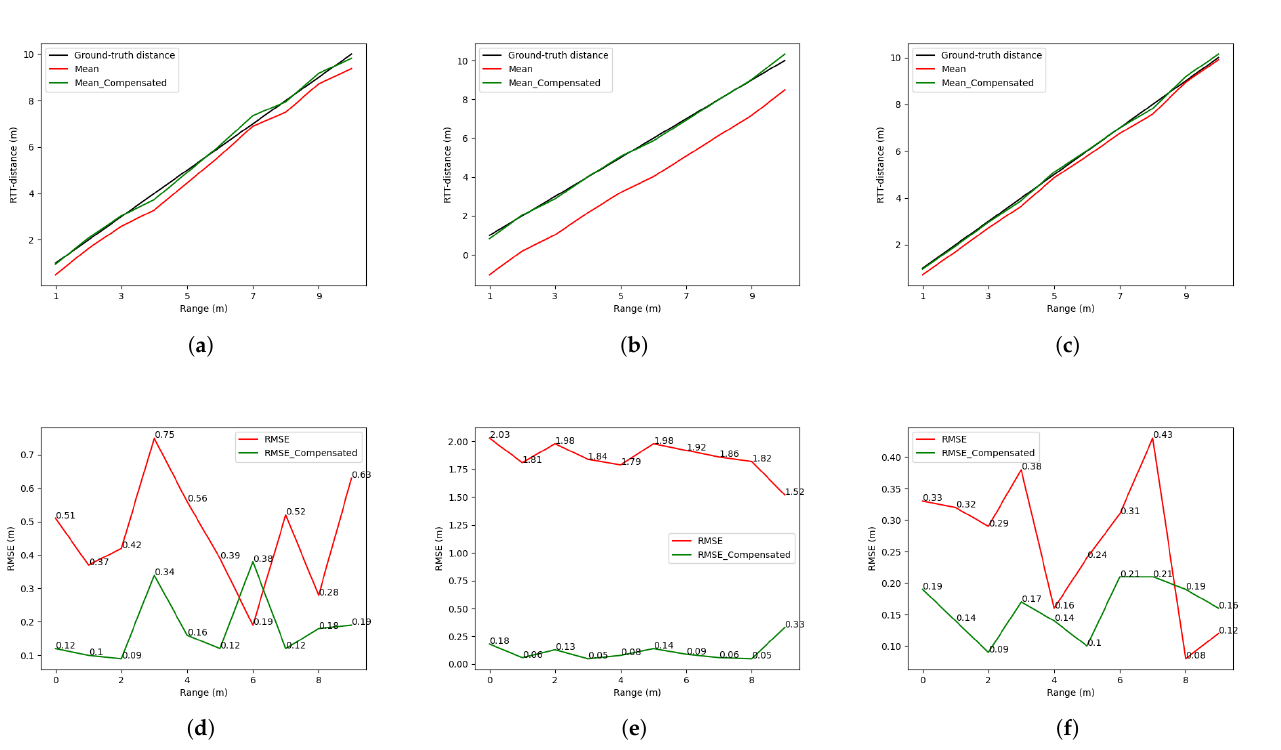
Figure 8. Wi-Fi RTT distance and error in RFPF and LOS condition: ( a ) Wi-Fi RTT distance from Google Pixel 2; ( b ) Wi-Fi RTT distance from Xiaomi Redmi K20; ( c ) Wi-Fi RTT distance from LG V50S; ( d ) RMSE of Wi-Fi RTT distance from Google Pixel 2; ( e ) RMSE of Wi-Fi RTT distance from Xiaomi Redmi K20; ( f ) RMSE of Wi-Fi RTT distance from LG